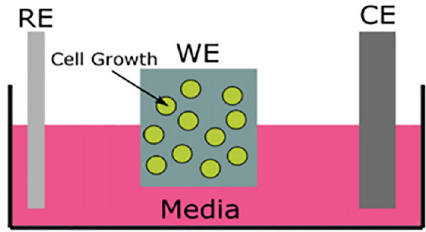
Fig. 1 Schematic of EIS